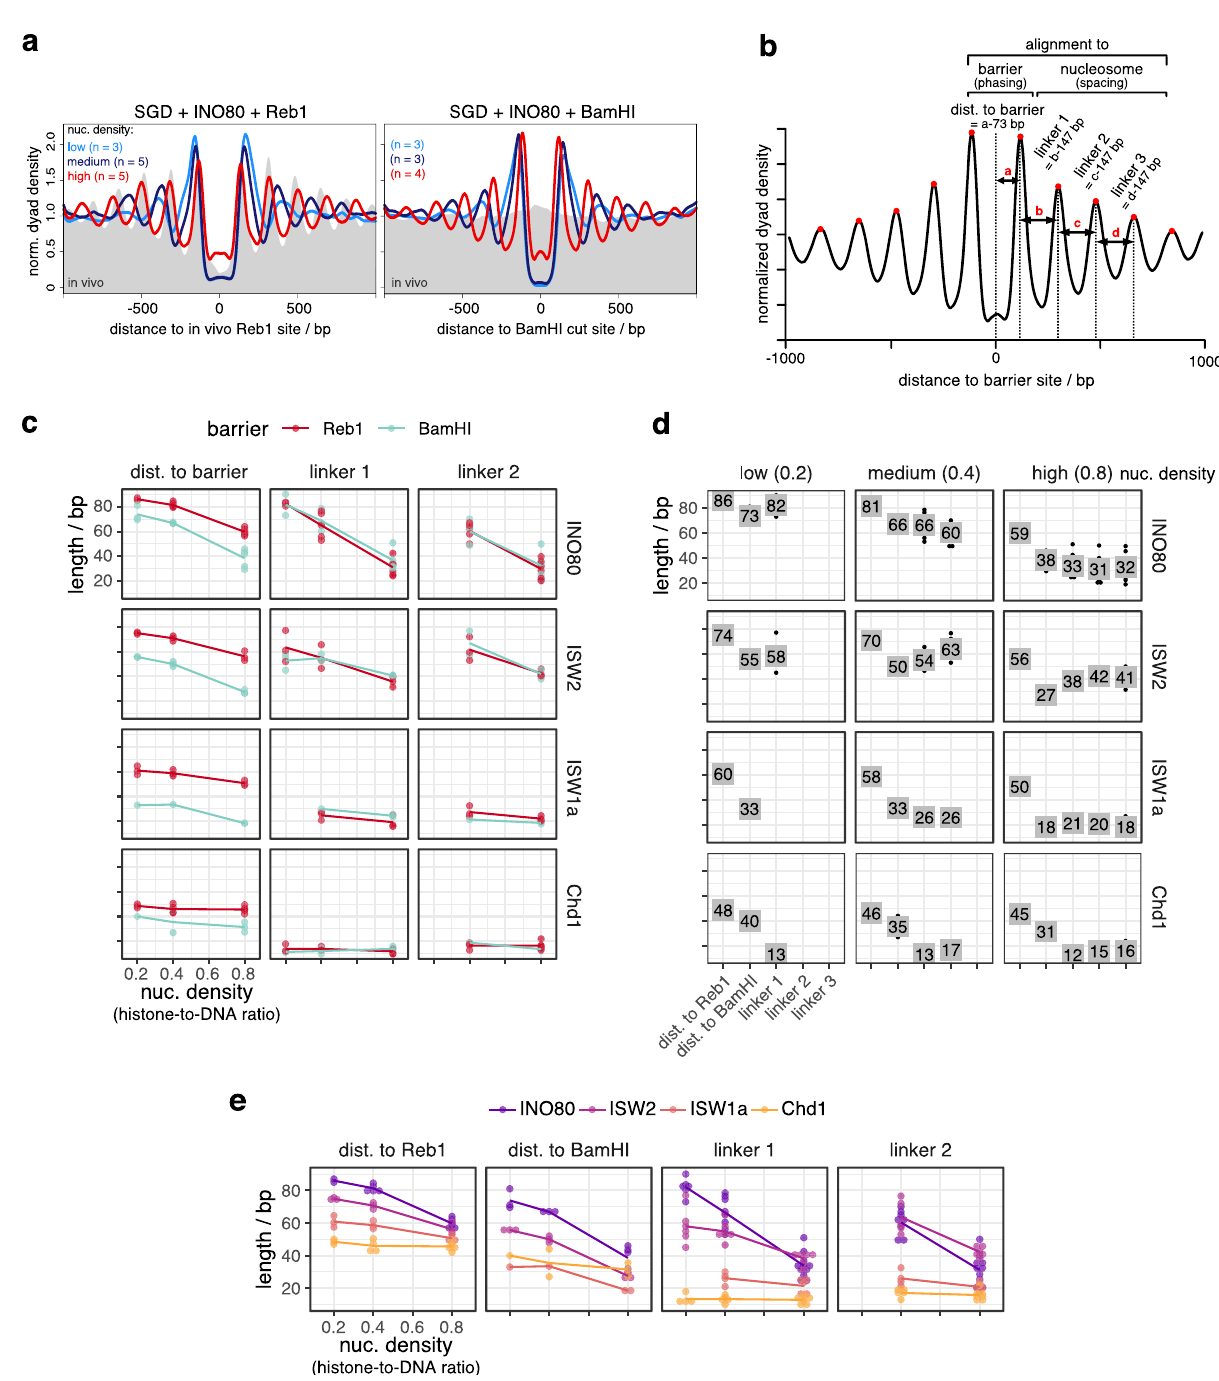
Fig. 2 Quanti fi cation of how barrier-aligned nucleosome array features depend on barrier type, remodeler type, and nucleosome density. a Composite plots of same MNase-seq data for INO80 and in vivo as in Fig. 1d but aligned at in vivo Reb1 sites (left), or at BamHI sites (right) of SGD chromatin reconstituted at the indicated nucleosome densities and incubated with INO80 and BamHI. b Scheme de fi ning array features quanti fi ed for barrier-aligned composite plots as in a . Array feature values for the indicated combinations of barrier, remodeler, and nucleosome density plotted in different ways allowing comparison between barriers (especially ( c )), values (especially ( d )), and remodelers (especially ( e )). Chd1 refers to the Chd1/FACT complex. Every dot in c – e represents one replicate; the lines in c and e and the numbers in d indicate the mean. Replicate dots are often hidden underneath numbered box in d . Composite plots of individual replicates for data shown in a , c – e in Supplementary Fig.